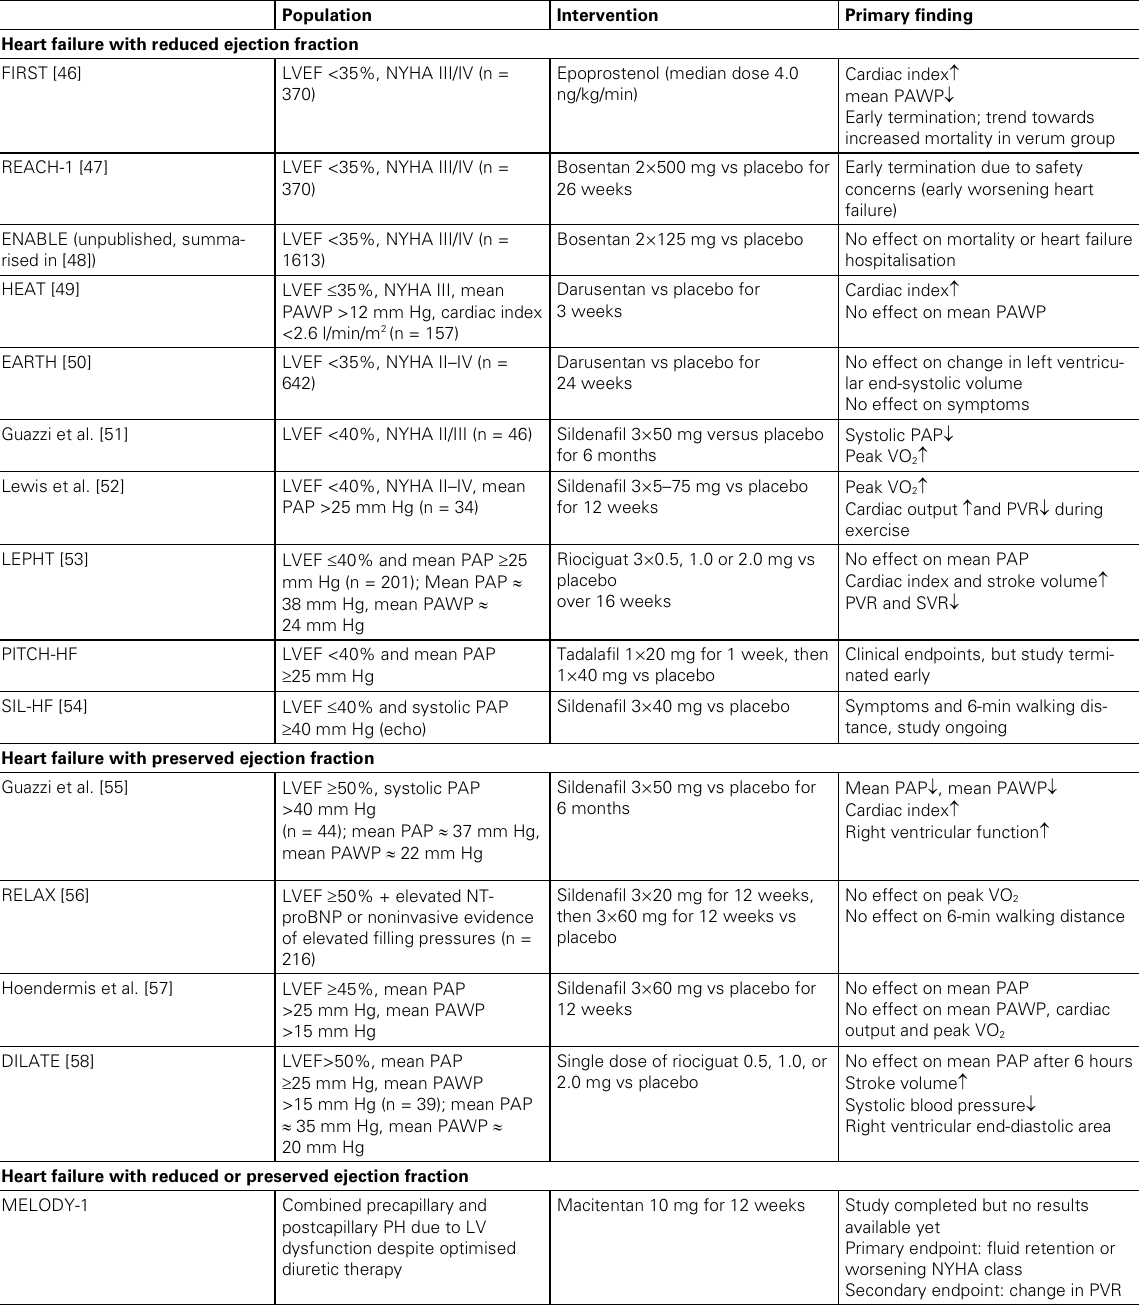
Table 6: Studies on pulmonary vasodilators in pulmonary hypertension associated with left heart disease and left heart diseases. Population Intervention Primary finding Heart failure with reduced ejection fraction FIRST